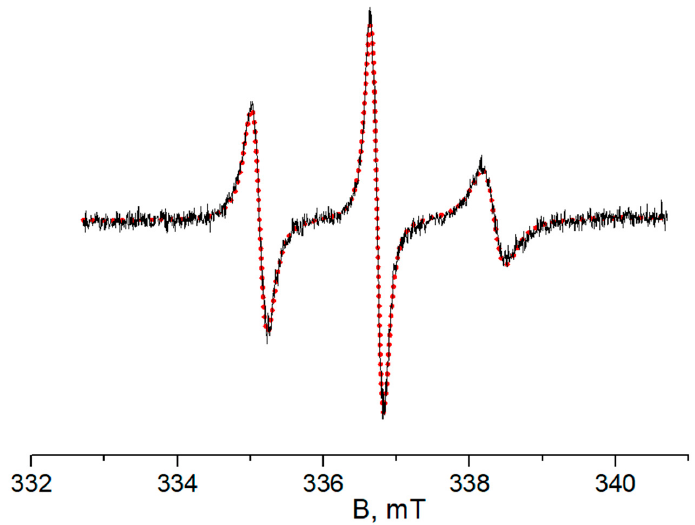
Figure 4. EPR spectra of TEMPO in globules of polymer V solution (5 wt%, PBS) in the presence of Cu 2+ ions recorded at 353 K. Black line—experimental spectrum, red dots—simulated spectrum. Parameters of simulated spectrum: g iso = 2.00607, a iso = 1.60 mT, t corr, x = 16 ns, t corr, y = 0.3 ns, t corr, z = 1.7 ns (t corr,iso =0.7 ns). Table 4. A iso, components of rotational correlation time tensors and isotropic rotational correlation time of TEMPO (type B species) in P(NIPAM- g- PLA) solutions in the presence of Cu 2+ ions at 343 K. Polymer